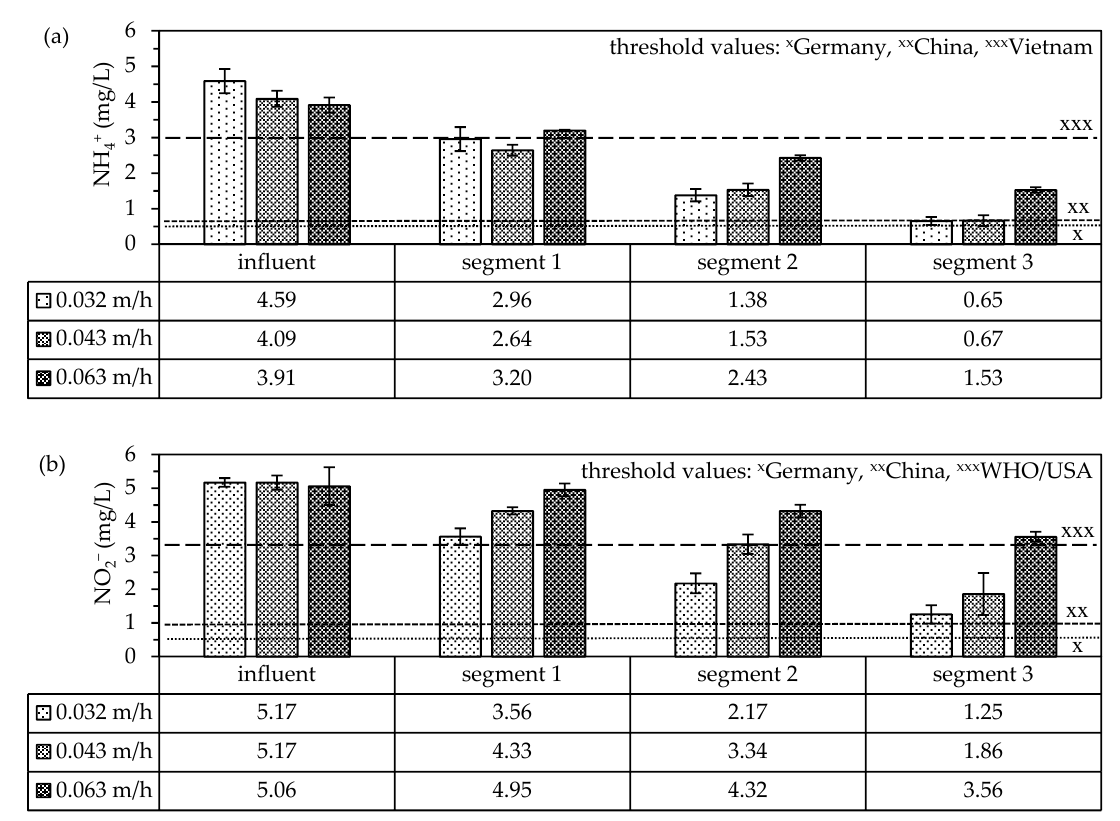
Figure 5. Comparison of local threshold values for NH 4+ ( a ) and NO 2 − ( b ) with the removal efficiency of the Anammox zeolite-biofilter depending on the filter velocity and filter’s height (matrix: Elbe-/tap water (1:10); v F = 0.032, 0.043, 0.068 m/h; c 0 (NH 4+ ) = 4.3 mg/L; c 0 (NO 2 − ) = 5.7 mg/L; c 0 (DOC) = 2.5 mg/L; pH: 7.8; T = 22 °C; n = 3). The Vietnam threshold value for NH 4+ was met at all filter velocities